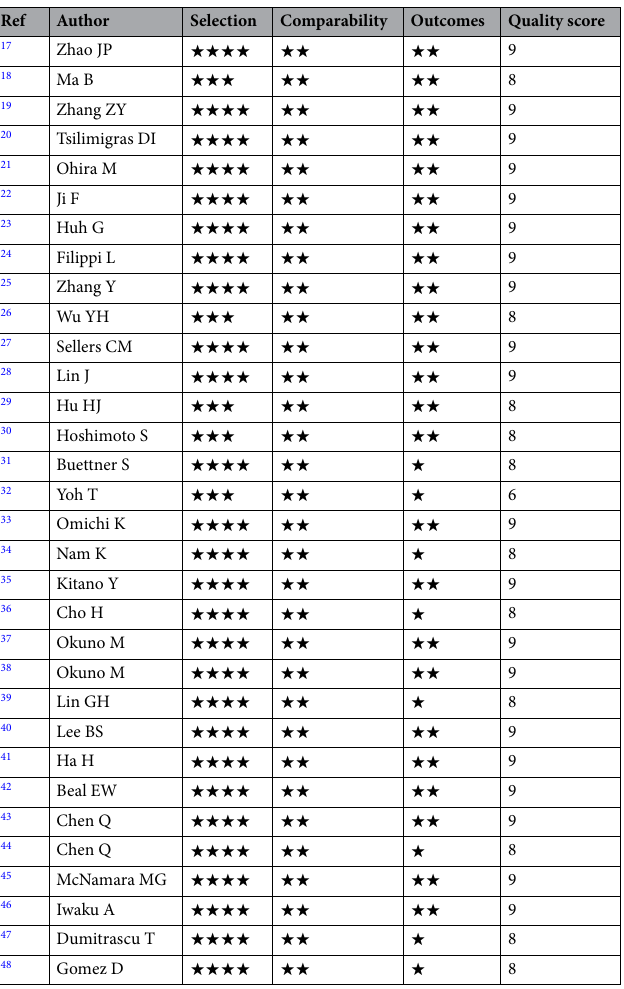
Table 2. Qualities of cohort studies are evaluated by modified Newcastle–Ottawa scale. The quality of the included studies was assessed under six items of Hayden et al. All included translational studies reporting oncological outcome were evaluated in accordance with the Newcastle–Ottawa scale. The maximum score of the scale is nine points with studies being categorized as low (0–3 points), moderate (4–6 points) and high quality (7–9 points),